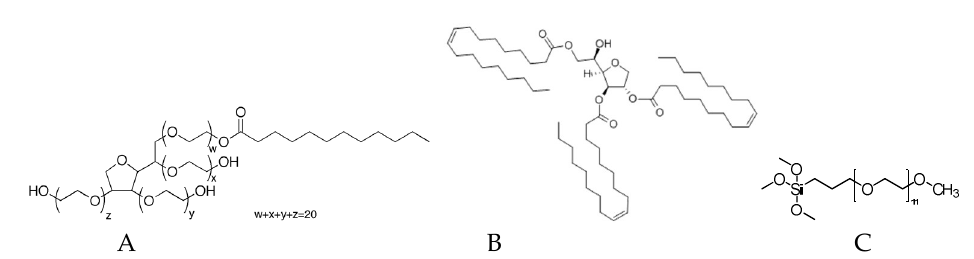
Figure 1. Chemical structure of additives ( A ) Tween 80, ( B ) Span 85, ( C ) PEG-silane.